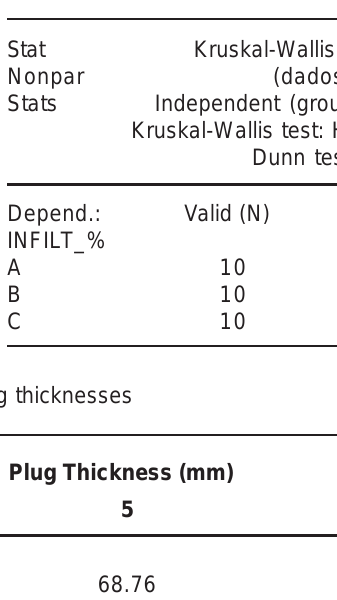
TABLE 5- Comparison among groups A (gray MTA), B